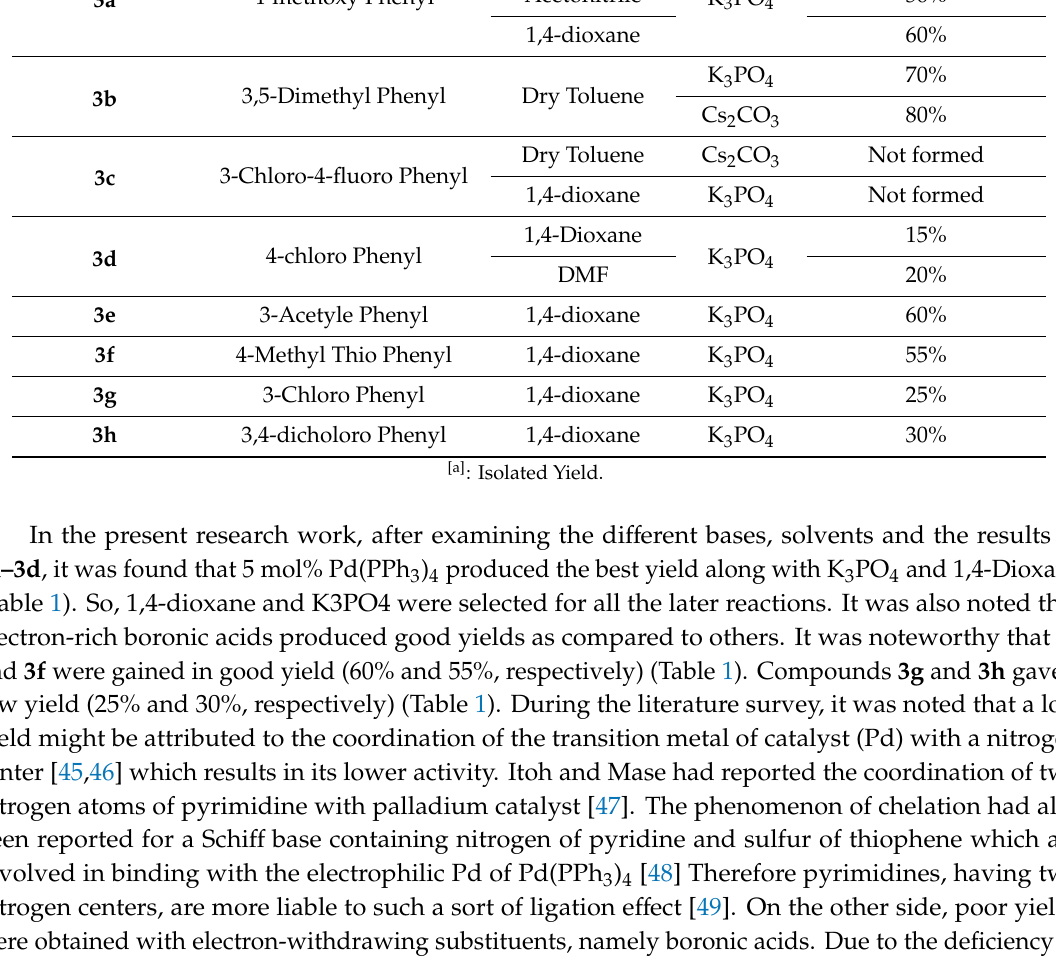
Table 1. Derivatives of 5-([1,1 (cid:48) -biphenyl]-4-yl)-4,6-dichloropyrimidine with percentage yields. Compounds Boronic Acid Solvent: H 2 O Base Percentage Yield [a] Dry 3a 4-methoxy Phenyl